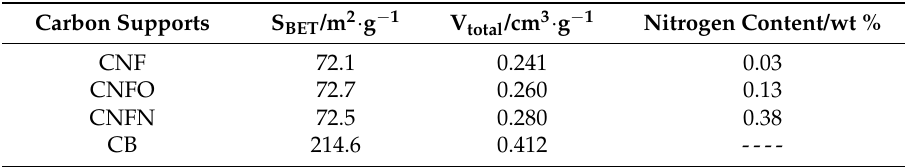
Table 1. Textural and chemical properties of carbon supports.